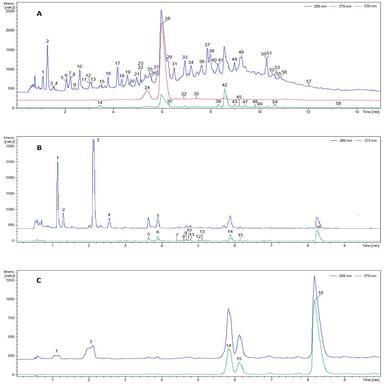
Chromatographic profile of the phenolic compounds for the DJP-US extract before hydrolysis at 280 nm, 370 nm and 530 nm (A) and after hydrolysis at 280 nm and 370 nm (B – Supernatant and C – Pellet washing).